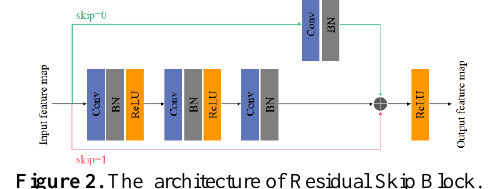
Figure 2. The architecture of Residual Skip Block.